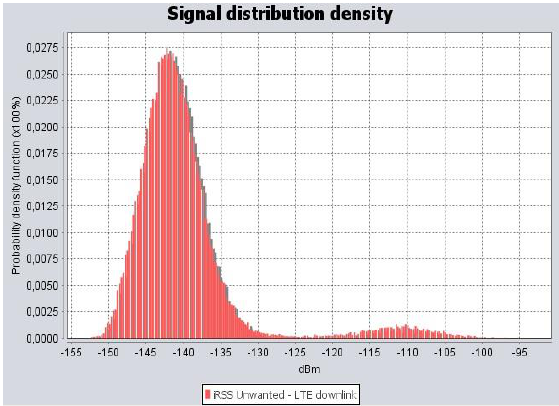
Fig. 13. Interference signal